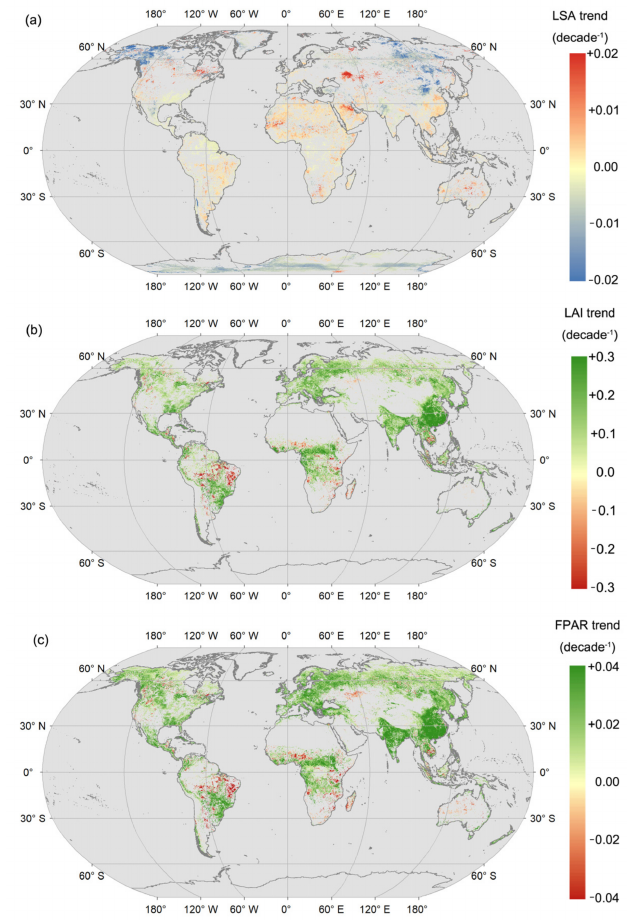
Figure 4. Spatial distributions of trends of the LSA, LAI, and FPAR from 2000 to 2019. ( a ) LSA trend, ( b ) LAI trend, and ( c ) FPAR trend. The pixels with no data are colored